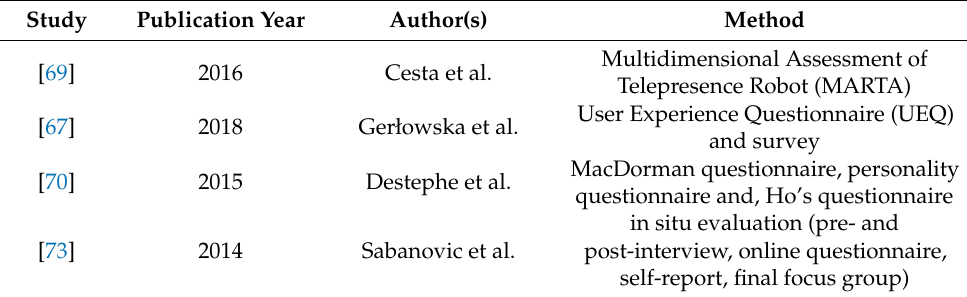
Table 3. UX evaluation method used in each